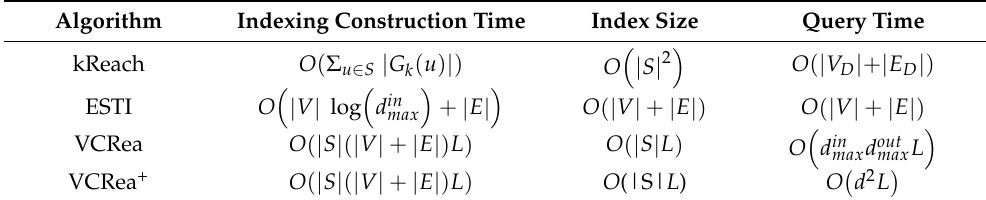
Table 2. Comparison of algorithms with respect to kHRQ processing on directed graphs with SCC s, where G k ( u ) is the subgraph of G that can be reached from u in k hops, D is the subgraph of G obtained by removing vertices in S, d in max ( d out max ) is the maximum in-degree (out-degree) for all vertices, and S = S ∪ S 1 ∪ S 2 ⊆ V . S 1 is the set of vertices with out-degree greater than d, and S 2 is the set of vertices with in-degree greater than d .